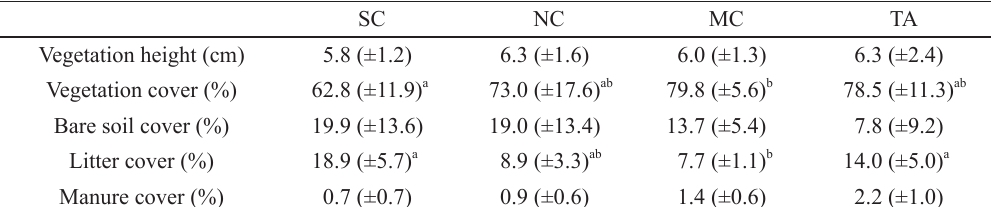
Structural parameters of coastal grasslands sampled in four different subregions in the South Brazilian’s coastal plain. Table II shows the mean values of the 60 plots per subregion and the respective standard deviation. Different letters represent significant difference between subregions (ρ<0.05).